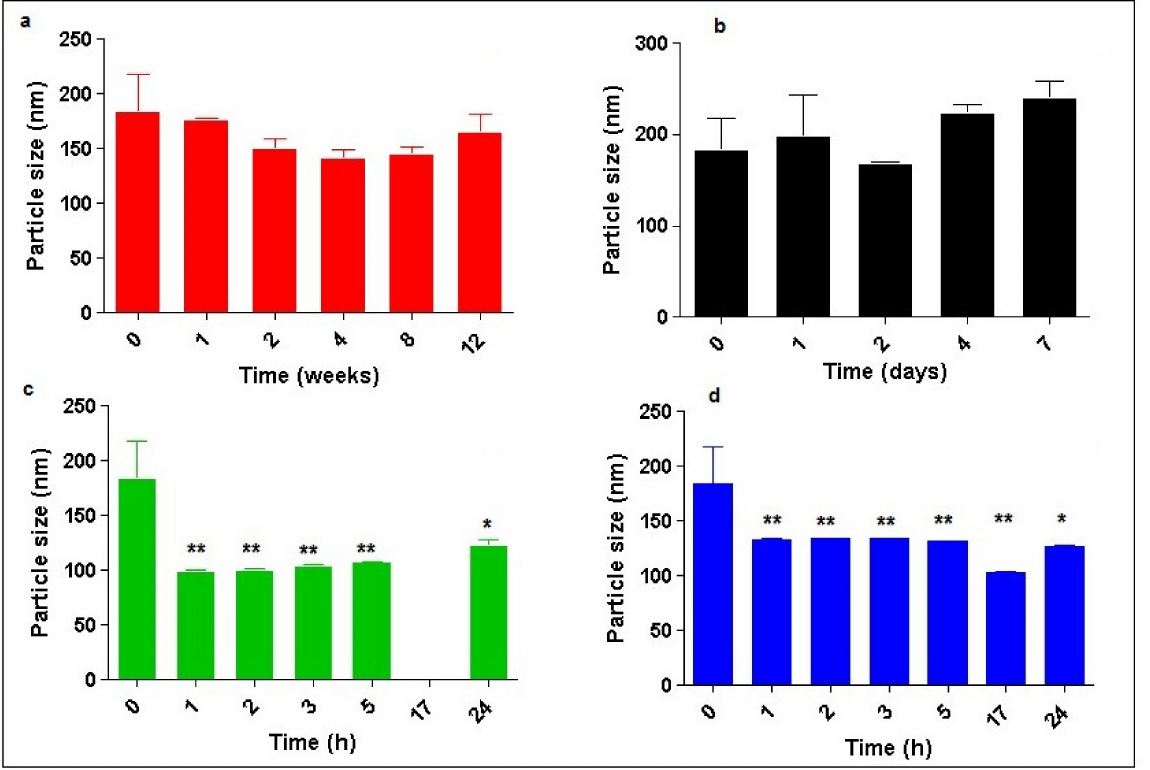
Figure 4. Particle size variations after storage of GSE/DA-SLN at 4 ◦ C (panel ( a )) or at 25 ◦ C (panel ( b )) or at 37 ◦ C in PBS pH 7.4 (panel ( c )) and at 37 ◦ C in SNF (panel ( d )); statistical significance: * p < 0.05, ** p < 0.01 vs. the starting particle size